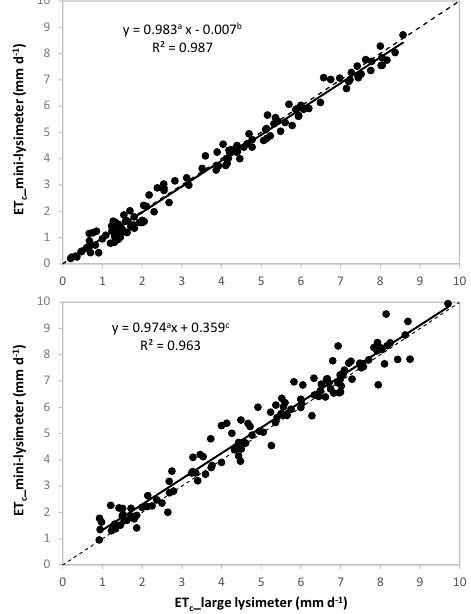
Figure 6. Large vs. mini-lysimeter ET c measurements at daily time step of barley ( top ) and potato ( bottom ). The number of records used for this evaluation was 128 and 131 for barley and potato, respectively. The line 1:1 is also plotted in the graphs (dashed line). a : the slope was highly significant different from 1 ( p < 0.01). b : the intercept was not significantly different from 0 ( p > 0.05). c : the intercept was highly significant different from 0 ( p < 0.01).